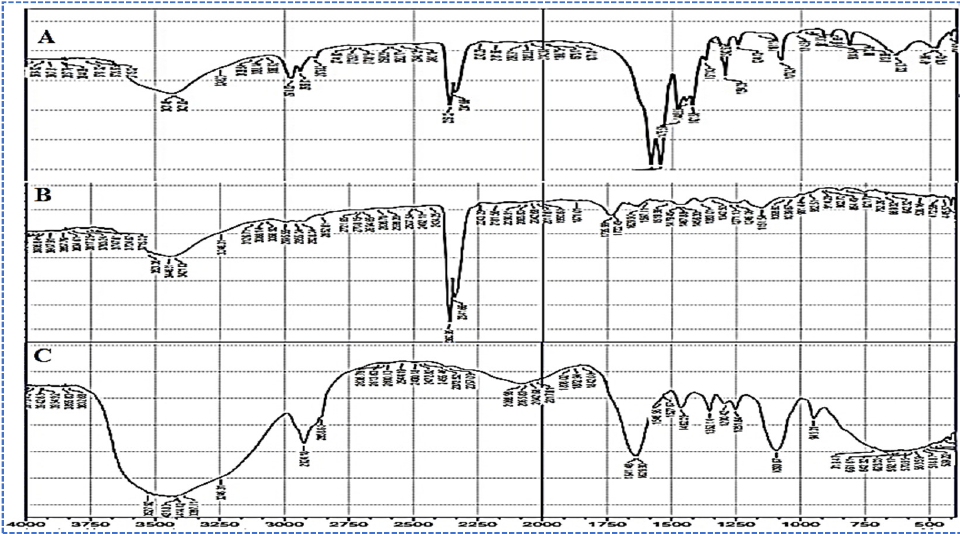
Figure 5. IR spectra of pure ALG ( A ), Eudragit RSPO ( B ), and optimized ALG-NPs ( C